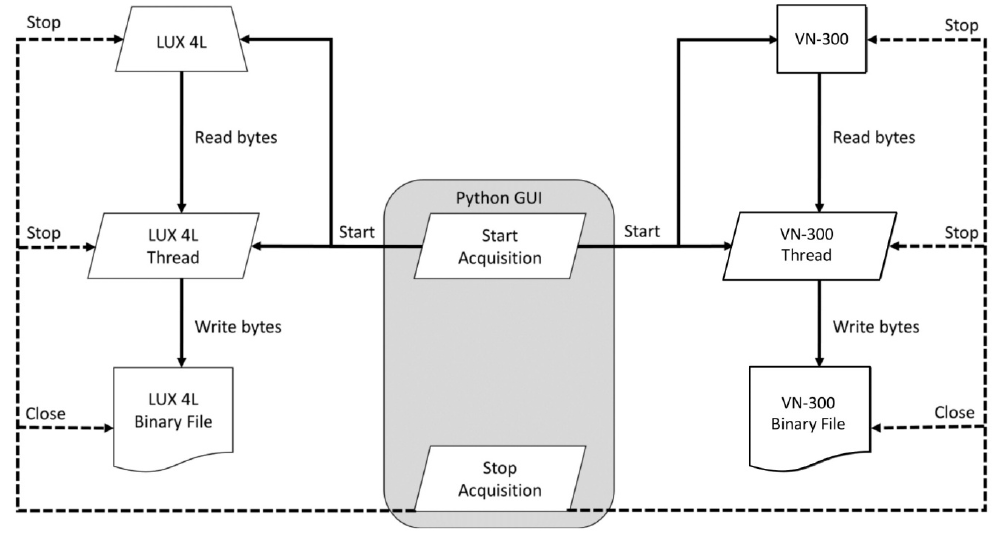
Figure 5. Workflow of the laser scanner LUX 4L and G NSS /INS VN-300 data acquisition process.